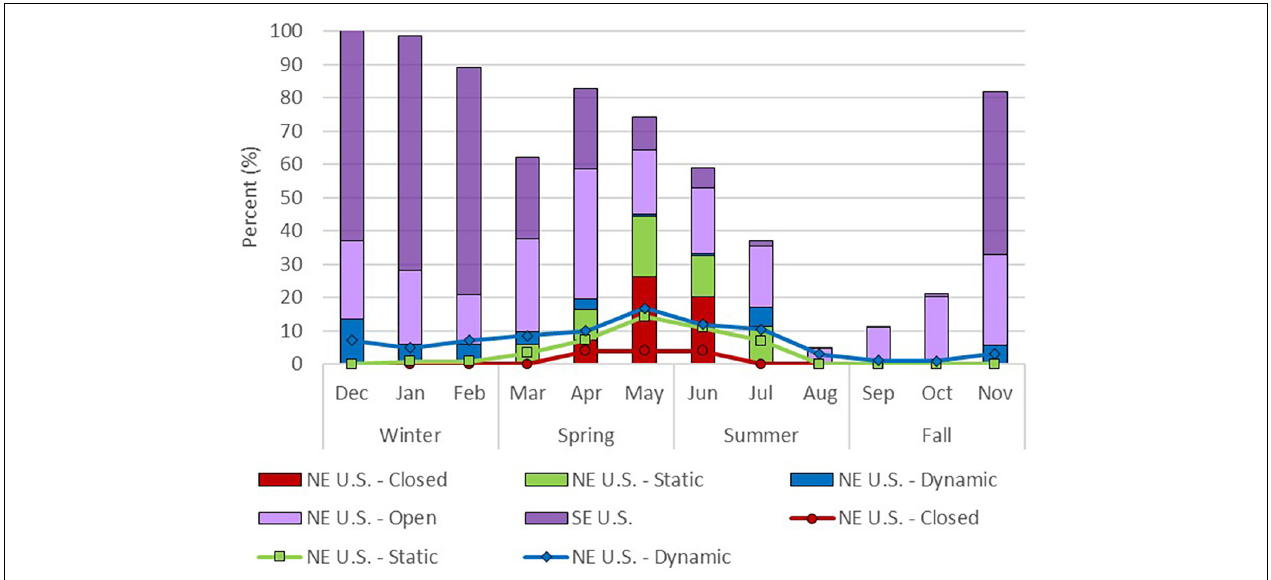
FIGURE 4 | The spatial temporal distribution of right whale population estimates (stacked bars) are compared to the share of northeast (NE) waters (stacked lines) dedicated to right whale management areas (April 2002–March 2009). Distribution of the right whale population in U.S. waters by month (stacked columns) and northeast right whale management areas including dynamic (blue), static (green), closed (red), and outside northeast management areas (i.e., open, light purple), as well as southeast (SE) waters below 40 degrees N latitude (dark purple). As much as 95% of the population estimates (August) based on Roberts et al. (2016) are not in U.S. waters; these shares unaccounted for may be in Canadian waters. In addition, the share of northeast ocean waters north of 40 degrees N latitude (stacked lines), monthly average, shows shares by right whale management area including dynamic (blue), static (green) and closed (red); remaining northeast waters are classified as “open.” At the maximum, 17% of northeast waters are dedicated to right whale management in May on